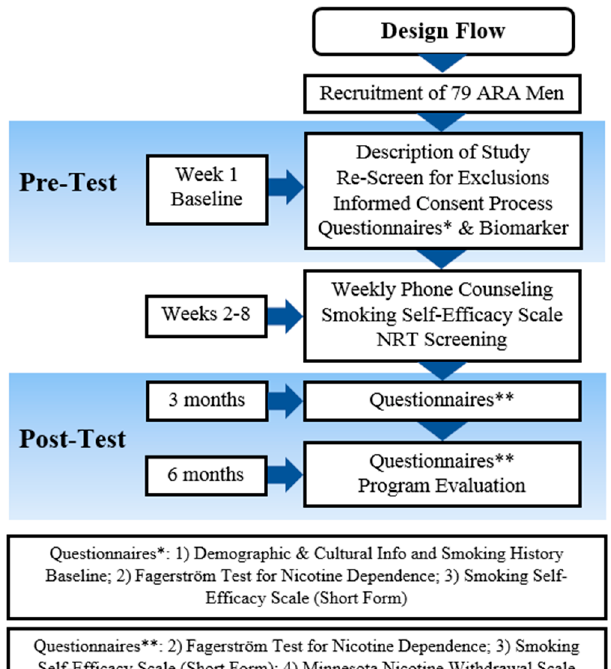
Figure 1. Study Timeline. (ARA: Arab American).